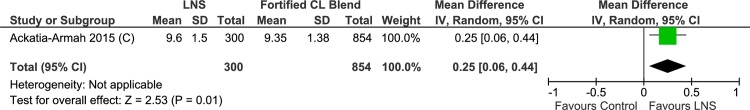
Forest plot: Lipid-based nutrient supplement versus Specially formulated micronutrient fortified foods, outcome: 1.25 Hemoglobin (Final).